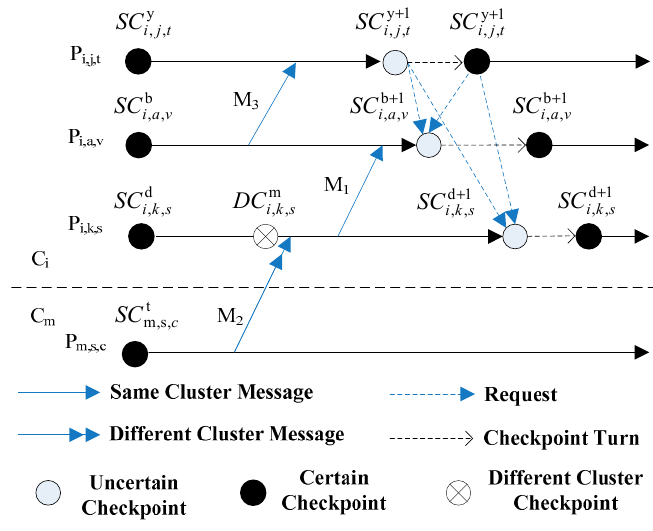
Figure 2. The model of hybrid checkpointing.